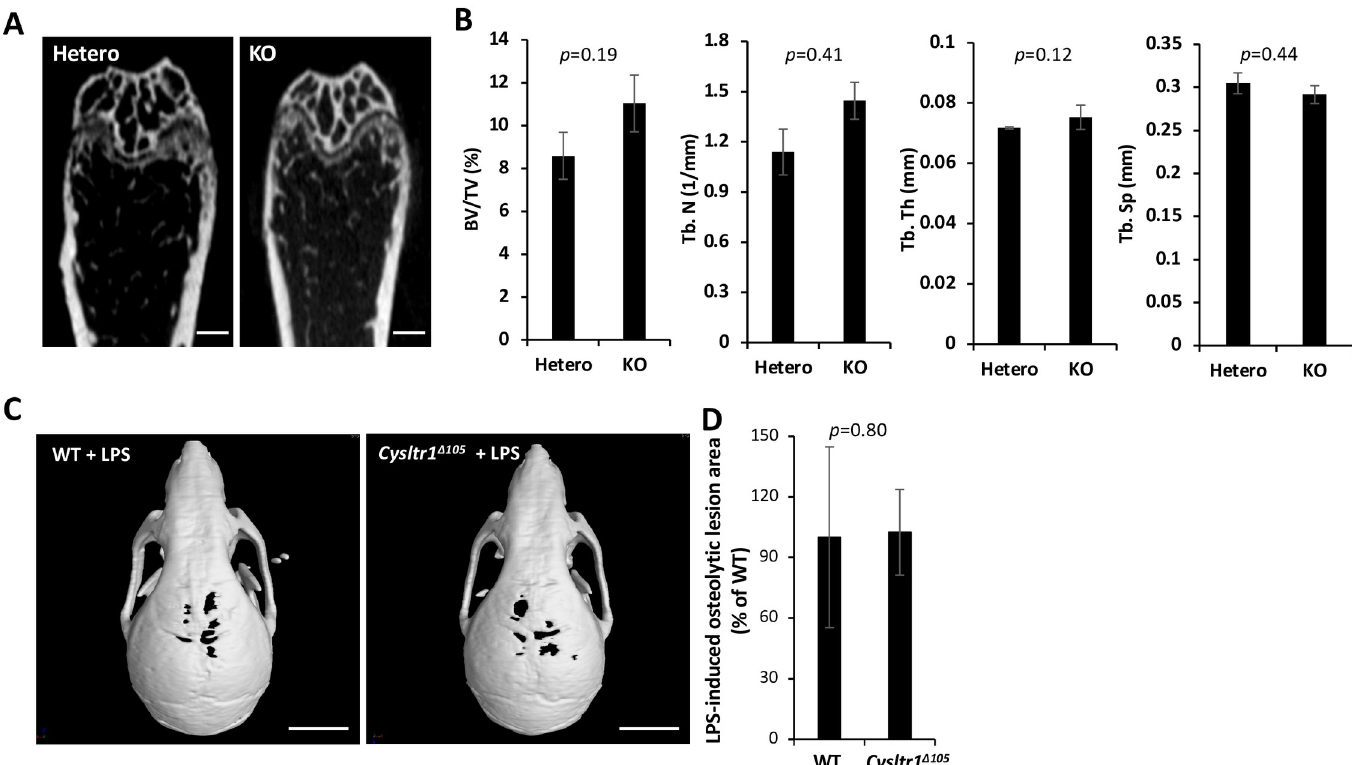
Fig 6. Cysltr1 gene disruption does not affect ovariectomy-induced osteoporosis or lipopolysaccharide-induced bone resorption. (A) Micro-computed tomography ( μ CT) images of ovariectomy-induced osteoporosis in the femur of Cysltr1 heterozygous and KO mice. Scale bars: 500 μ m. (B) Trabecular bone volume per tissue volume (BV/TV), trabecular number (Tb.N), trabecular thickness (Tb.Th), and trabecular separation (Tb.Sp) in the metaphyseal region of the ovariectomized mouse femur. Each sample, n = 5. (C) CT images of lipopolysaccharide (LPS)-induced bone erosion in WT and Cysltr1 Δ 105 mice. The calvaria of WT and Cysltr1 Δ 105 mice treated with LPS for 5 days to induce inflammatory bone destruction were analyzed using an animal CT scanner and 3D construction software. Scale bars: 5 mm. (D) Cysltr1 Δ 105 did not alter the osteolytic lesion area from that in WT. Osteolytic areas were analyzed with ImageJ software. WT, n = 4; Cysltr1 Δ 105 , n = 5.